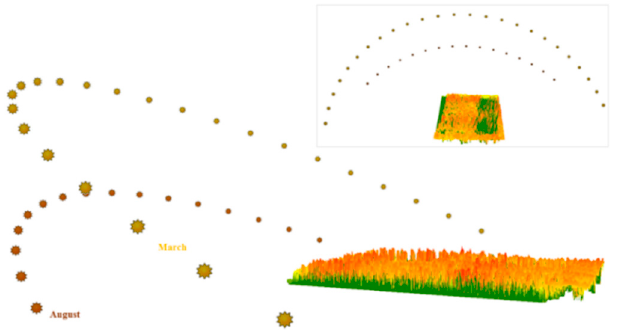
Figure 8. Illustration of the azimuth and sun elevation in two different seasons at the beginning and at the end of the growing season.